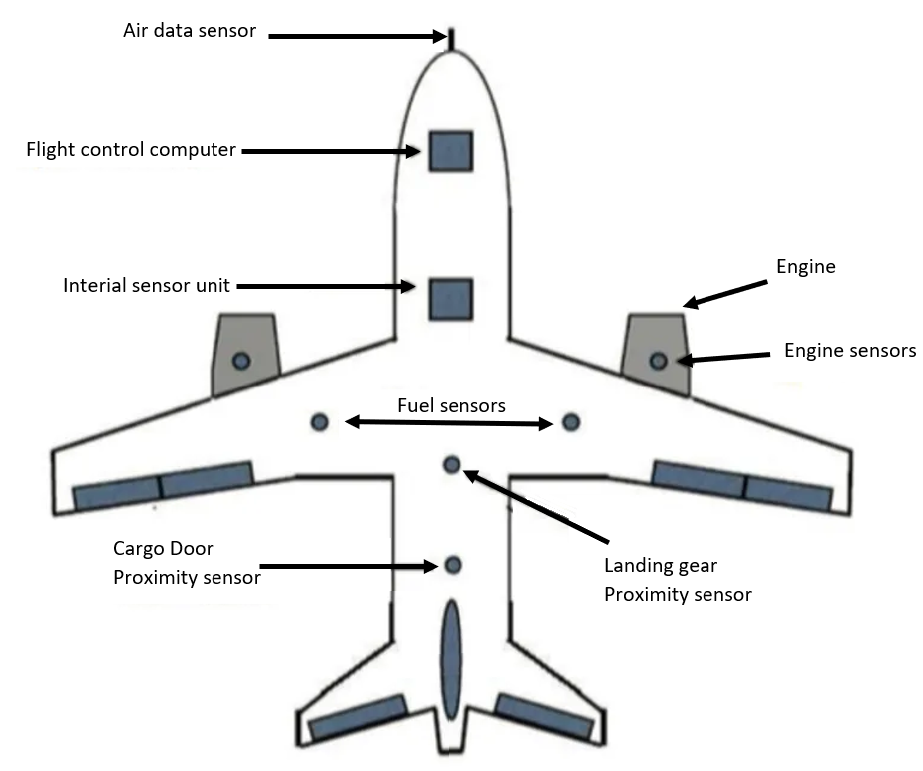
Figure 5. Graphical representation of different wired sensors distribution all over the aircraft [33].